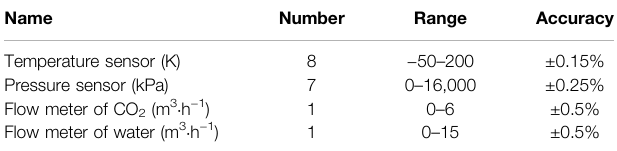
TABLE 2 | Measurement devices.